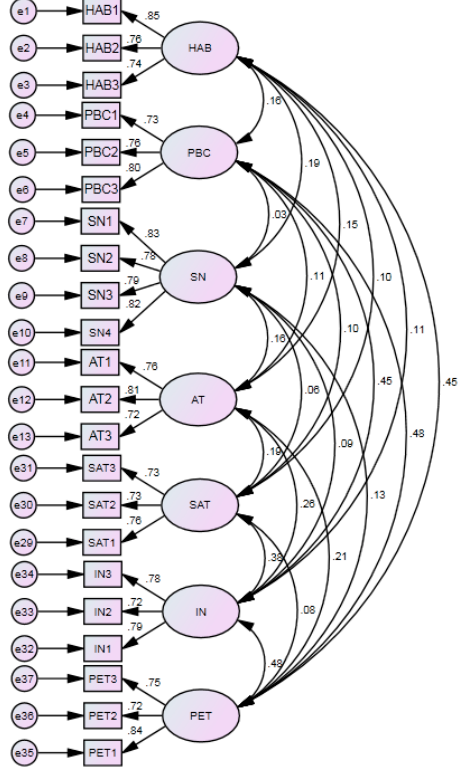
Figure 3. Confirmatory factor analysis: model 2.